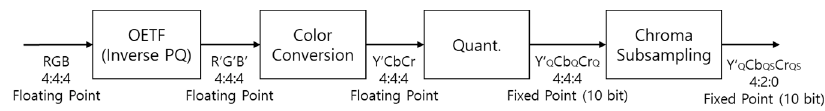
Figure 1. Conventional preprocessing stages for high dynamic range and wide color gamut (HDR/WCG) video in